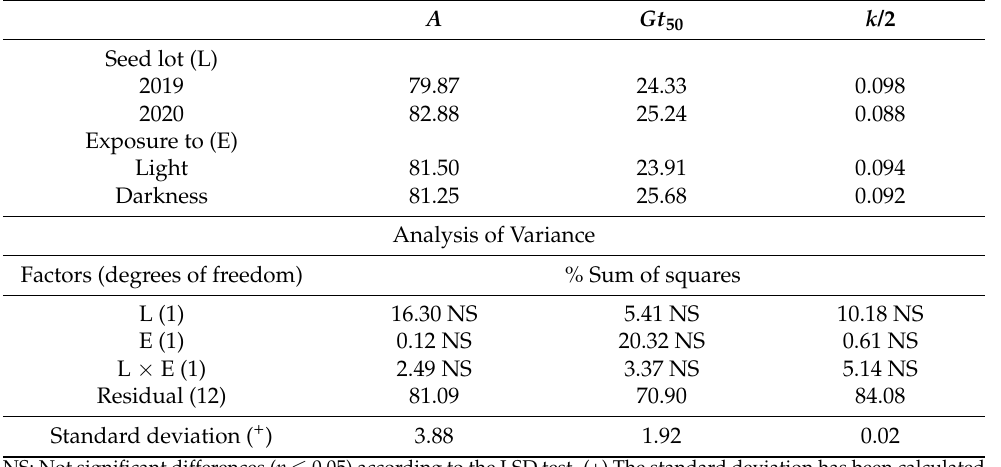
NS: Not significant differences ( p ≤ 0.05) according to the LSD test. (+) The standard deviation has been calculated as the square root of the residual mean square.